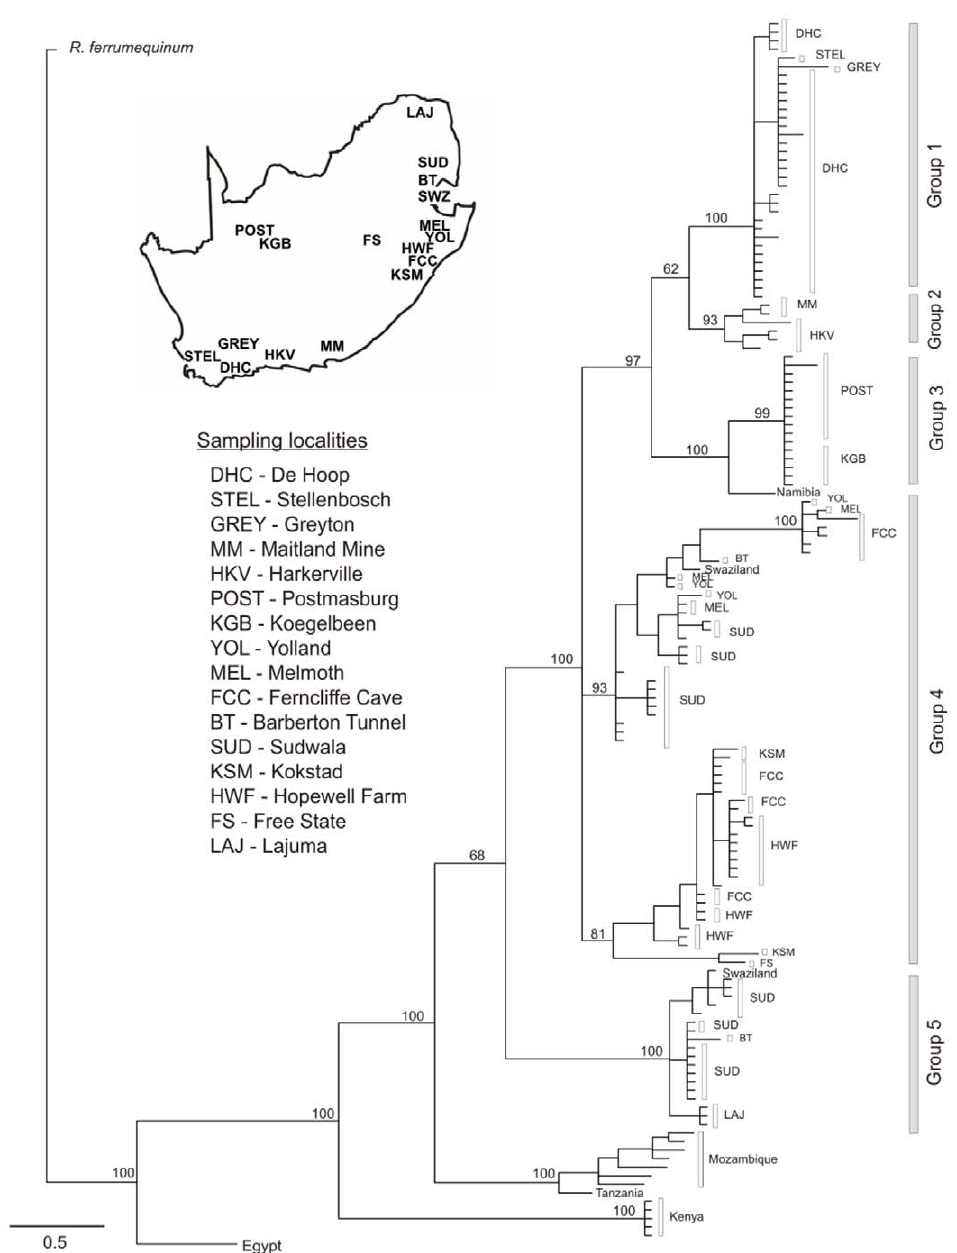
Figure 2. BI consensus topology. Values above nodes represent posterior probabilities. Grey bars indicate the five groups used in analyses of southern African bats. South African sampling localities are depicted graphically on the